Question: Briefly state, in one sentence, what is plotted here.
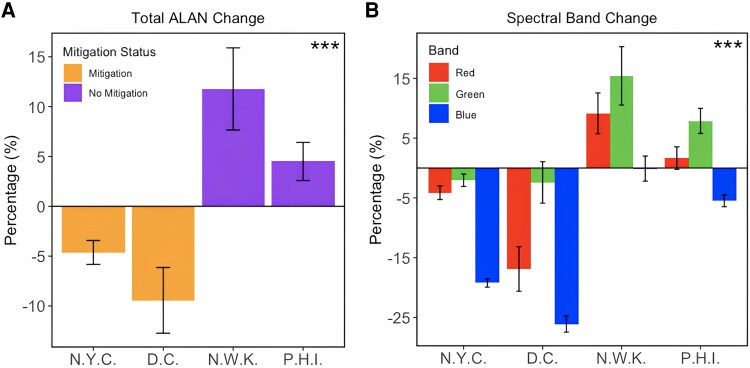
Answer: Percent change in ALAN across four study cities from 2022 to 2023. The percentage change in ALAN brightness (a) and in each spectral band (b) in each city. The percentage change was calculated by subtracting the 2022 value from the 2023 value and dividing the result by the 2022 value. N.Y.C., New York City; D.C., Washington DC; N.W.K., Newark; P.H.I., Philadelphia. Error bars represent 1 SE and *** denotes the statistically significant reductions (2023–2022) with P < 0.001.